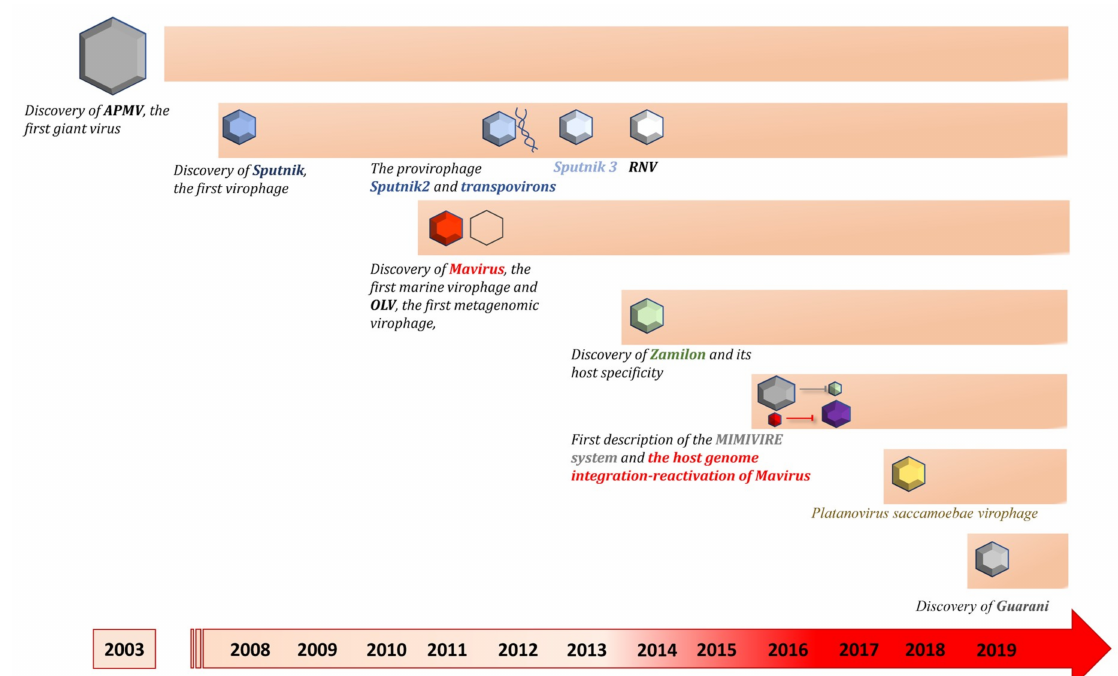
Figure 1. Timeline showing the chronological order of description of virophages isolated by co-culture and the major discoveries in the virophage field. RNV: Rio Negro Virophage. OLV: Organic Lake